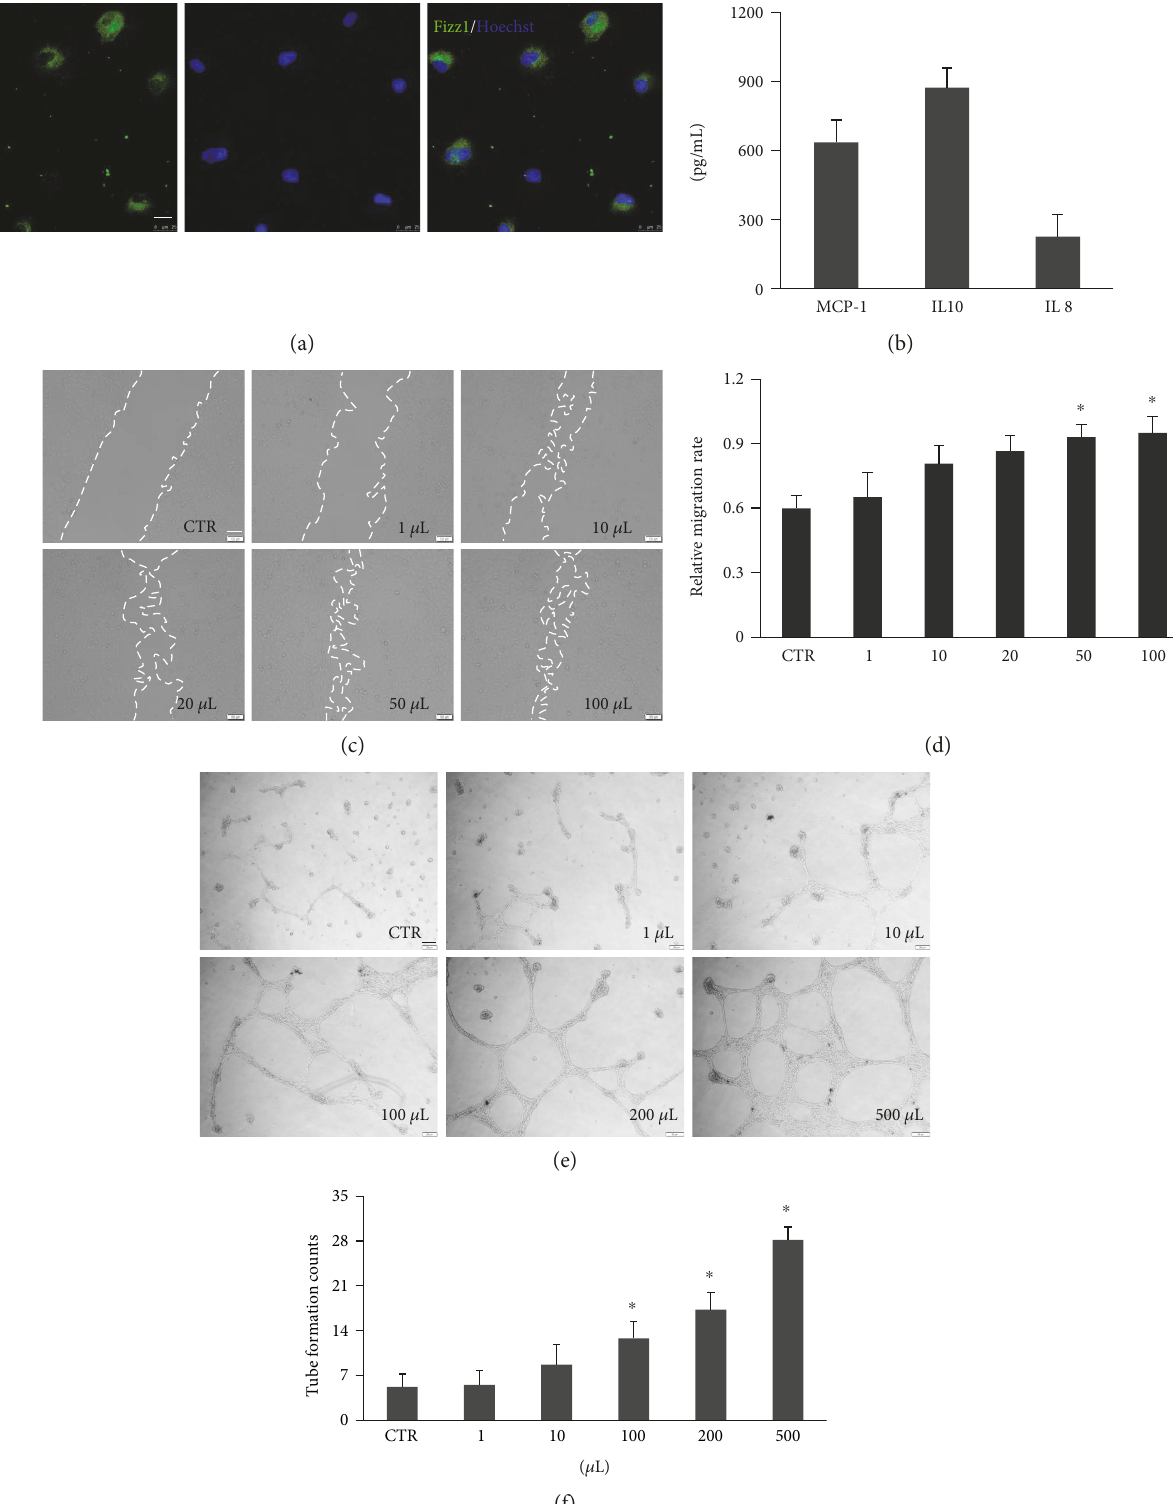
Figure 5: M2-CM enhanced EC vasculogenesis in vitro. (a) M2 macrophage induction identi fi cation by IF staining for M2 marker Fizz 1. Scale bar =20 μ m. (b) MCP-1, IL 10, and IL 8 released by M2 macrophage. (c) M2-CM promoted EC migration at 24 h through scratch assay. Scale bar =100 μ m. (d) Analysis of relative migration rate of ECs after M2-CM stimulation for 24 h. (e) Typical images of the tube- like structures in the presence of M2-CM cultured on Matrigel at 18 h. Scale bar =200 μ m. (f) Analysis of tube formation counts of di ff erent additions of M2-CM. Data were mean ± SEM of three independent experiments. ∗ p < 0 05 versus CTR